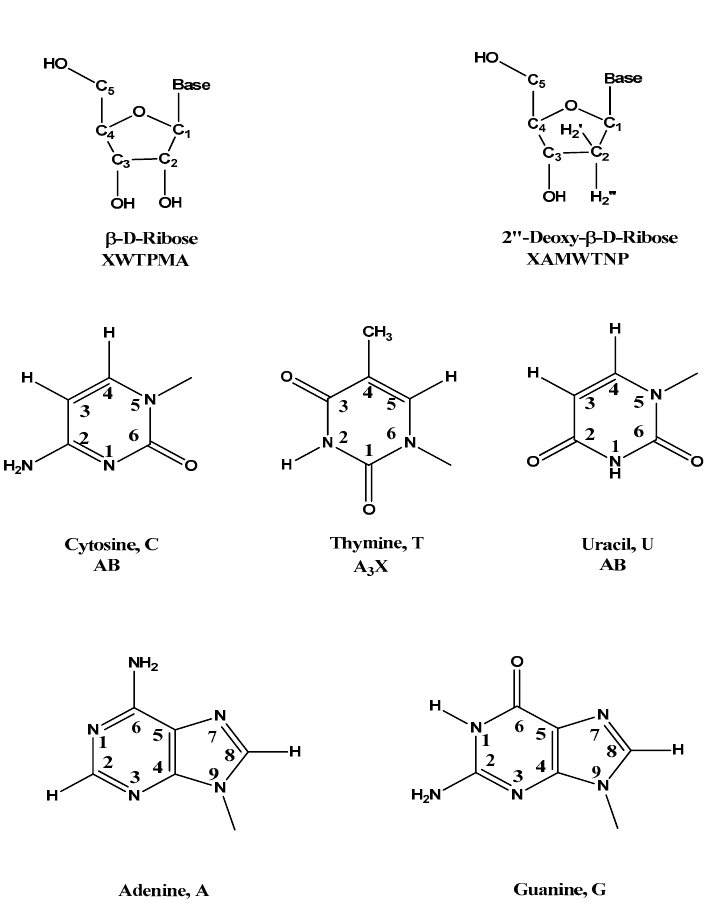
Figure 1. The structures, symbols, and 1 H spin systems of the β - D -riboses, 2 ′′ -deoxy- β - D -riboses, and five common bases in DNA and RNA. (Modified according to the reference [67]). Table 1. Approximate 1 H chemical shift ranges in single-stranded and duplex DNA and RNA fragments. (Modified according to the reference [67]).